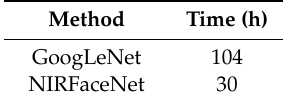
Table 7. Processing times of all the methods.